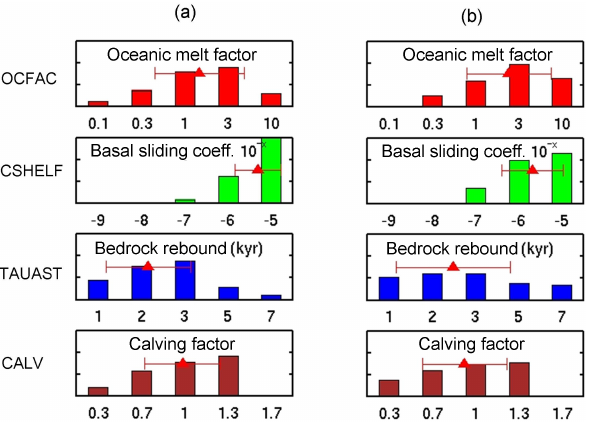
Figure C2. Ensemble-mean scores for individual parameter values, using the simple averaging method as in Fig. 3. (a) Using the close-to- Gaussian scoring approach (a) (Sect. 2.4, Appendix B). (b) Using the more heuristic approach (b) (Sect. 2.4, Appendix B), exactly as in